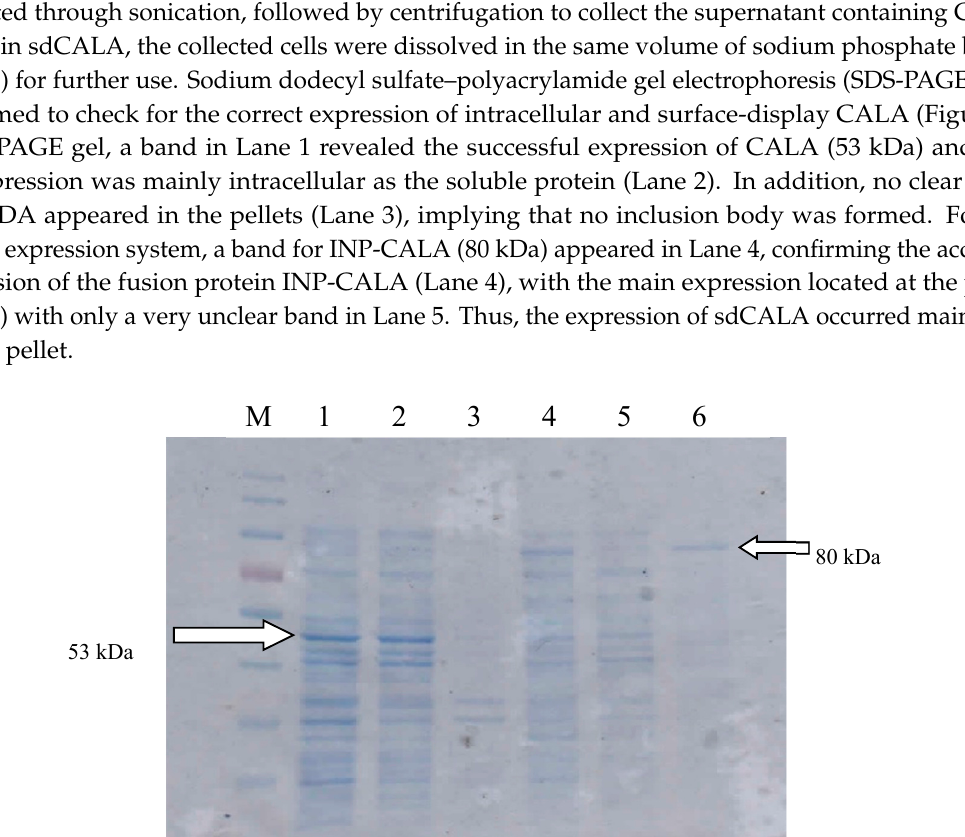
Table 1. Expression and activities of intracellular CALA and surface-displayed CALA.